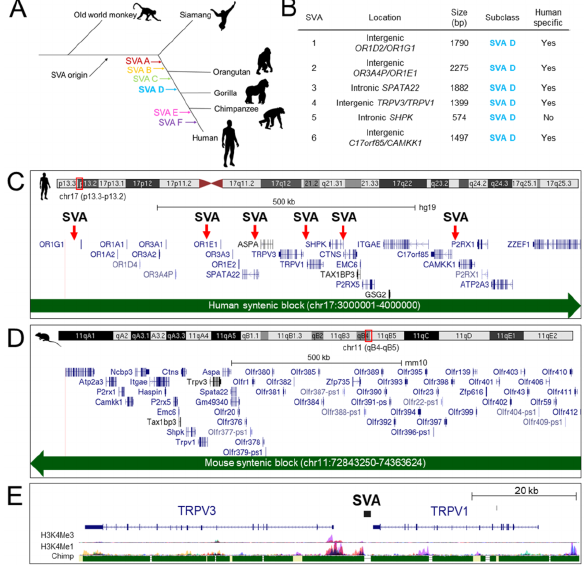
Figure 1. Chr17p13.2 is enriched for human specific SVA D insertions. ( A ) Schematic showing the emergence of short interspersed nuclear element-variable number tandem repeat (SINE-VNTR)- Alu (SVA) subclasses throughout primate evolution. SVA subclasses A, B, and C are evolutionarily older and are found in multiple primate species, whereas subclasses SVA E and SVA F emerged following divergence with the chimpanzee last common ancestor and are therefore human specific (adapted from Wang et al. 2005) ( B ) Summary of SVA D insertions at chr17p13.2. ( C ) A gene dense region (chr17:3000001–4000000, hg19) at chr17p13.2 contains 6 SVA D insertions. ( D ) The syntenic region in the mouse genome (chr11:72843250–74363624, mm10) contains orthologous genes conserved at chr11qB4-B5 in the opposite orientation to that displayed in the human genome. ( E ) UCSC image showing human specific SVA insertion at the TRPV1/TRPV3 intergenic region respect to adjacent genes. H3K4Me3 and H3K4Me1 histone marks are shown, highlighting regulatory domains. Conservation with the chimpanzee genome is also provided to assess SVA status as primate or human